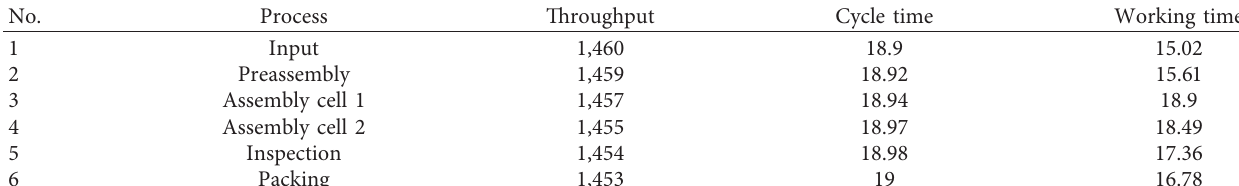
Table 3: Throughput, cycle time, and working time for each process in the line.